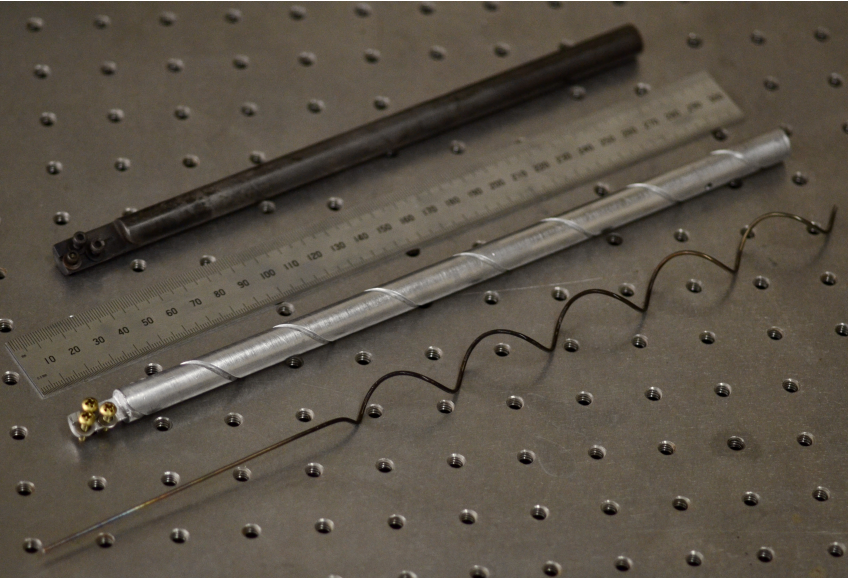
Figure 4. Image of a model flagellum (helix), forming mandrel (bright aluminum), and annealing rod (oxidized stainless steel). The aluminum forming mandrel had helical V-shaped grooves that were used to create model flagella with different wavelengths. After forming, the flagella were annealed on a smooth precision annealing rod to increase uniformity in the radius ( ∆ R < 0.1 mm). The helical parameters are listed in Table 3.